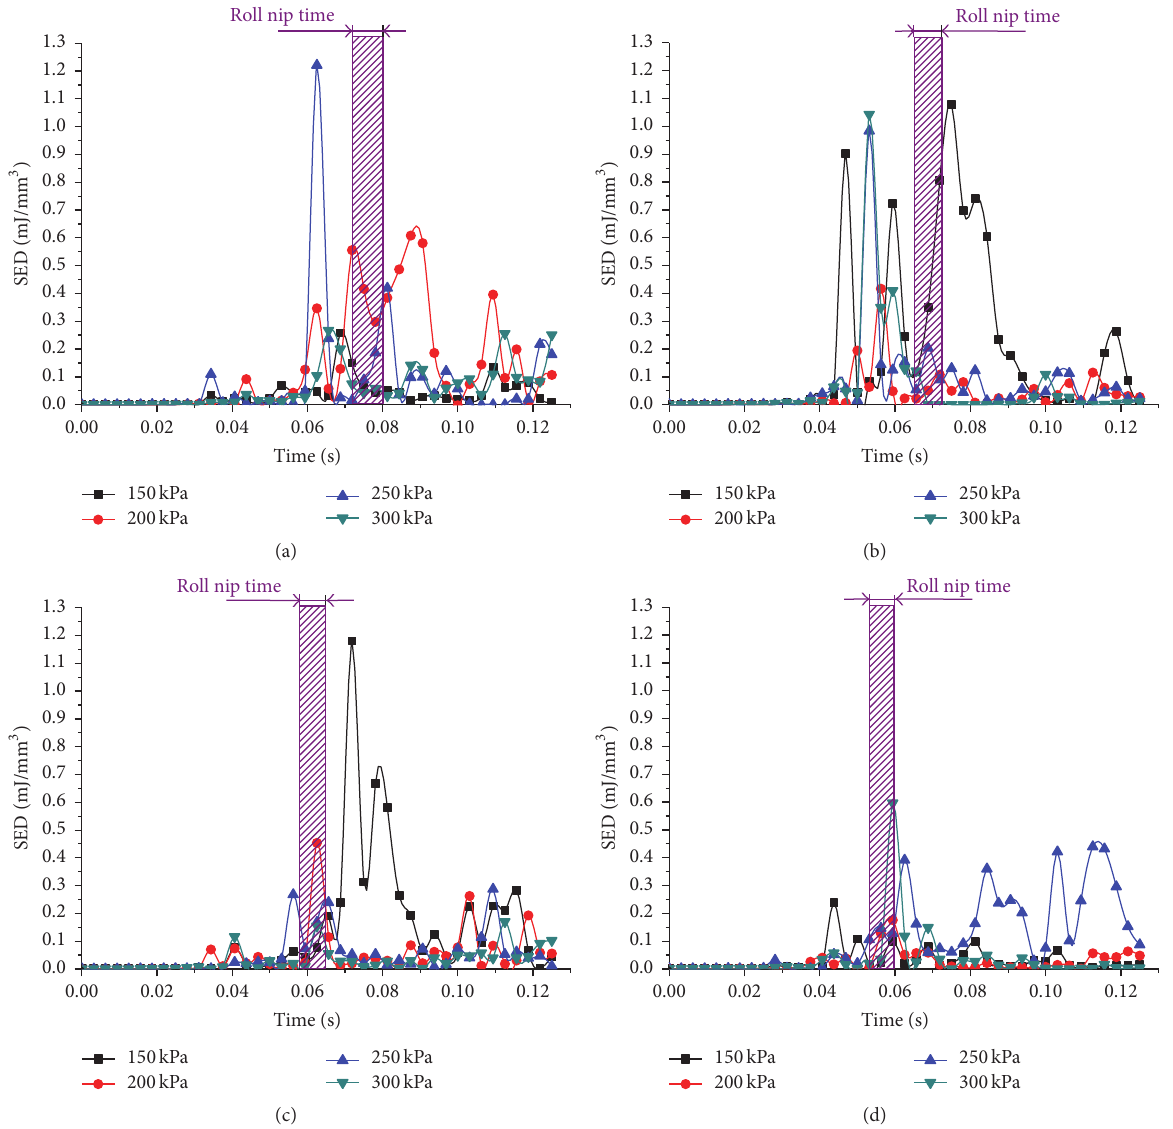
Figure 7: Curves of SED in number 175 mesh under different processing parameters in AFP process: (a) laying speed of 27 m/min; (b) laying speed of 30 m/min; (c) laying speed of 33 m/min; (d) laying speed of 36